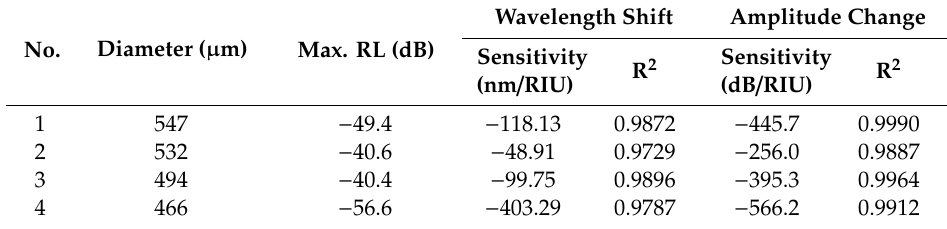
Table 2. Figures of merit and performance metrics of the four ball resonators reported in this work.